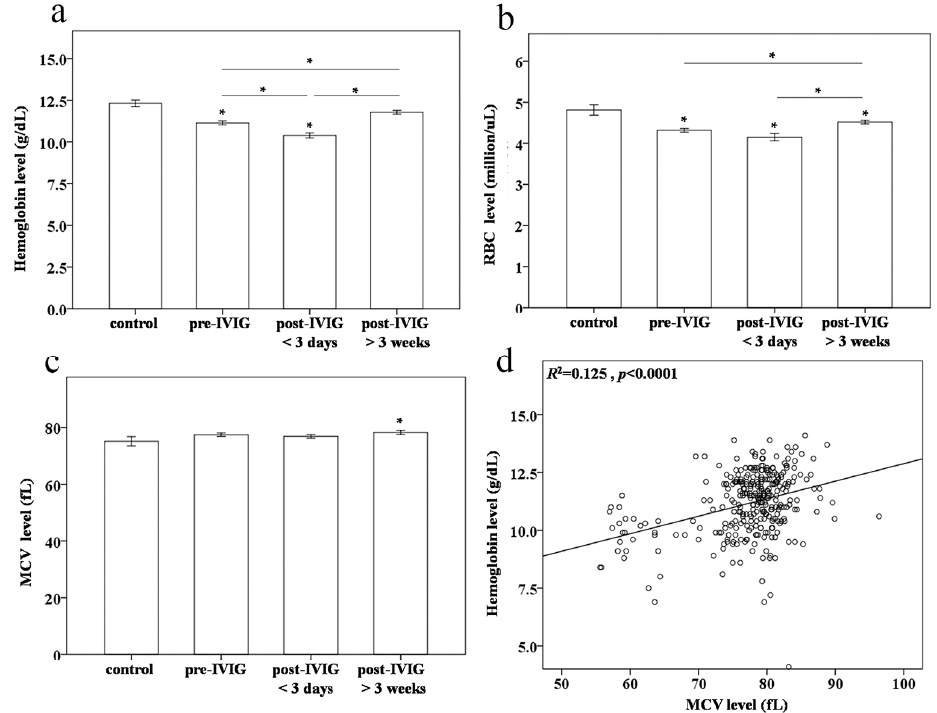
Figure 1. Comparison of ( a ) hemoglobin levels; ( b ) red blood cell (RBC) counts; and ( c ) mean corpuscular volume (MCV) between controls ( N = 20), and patients with Kawasaki disease (KD) ( N = 100) before and after undergoing intravenous immunoglobulin (IVIG) treatment; ( d ) Univariate analysis shows that the hemoglobin levels were positively and significantly correlated with MCV levels in both KD patients and the control subjects ( R 2 = 0.125, p < 0.0001). Data are presented as mean ± standard error. * indicates p < 0.05 between the control and KD groups.